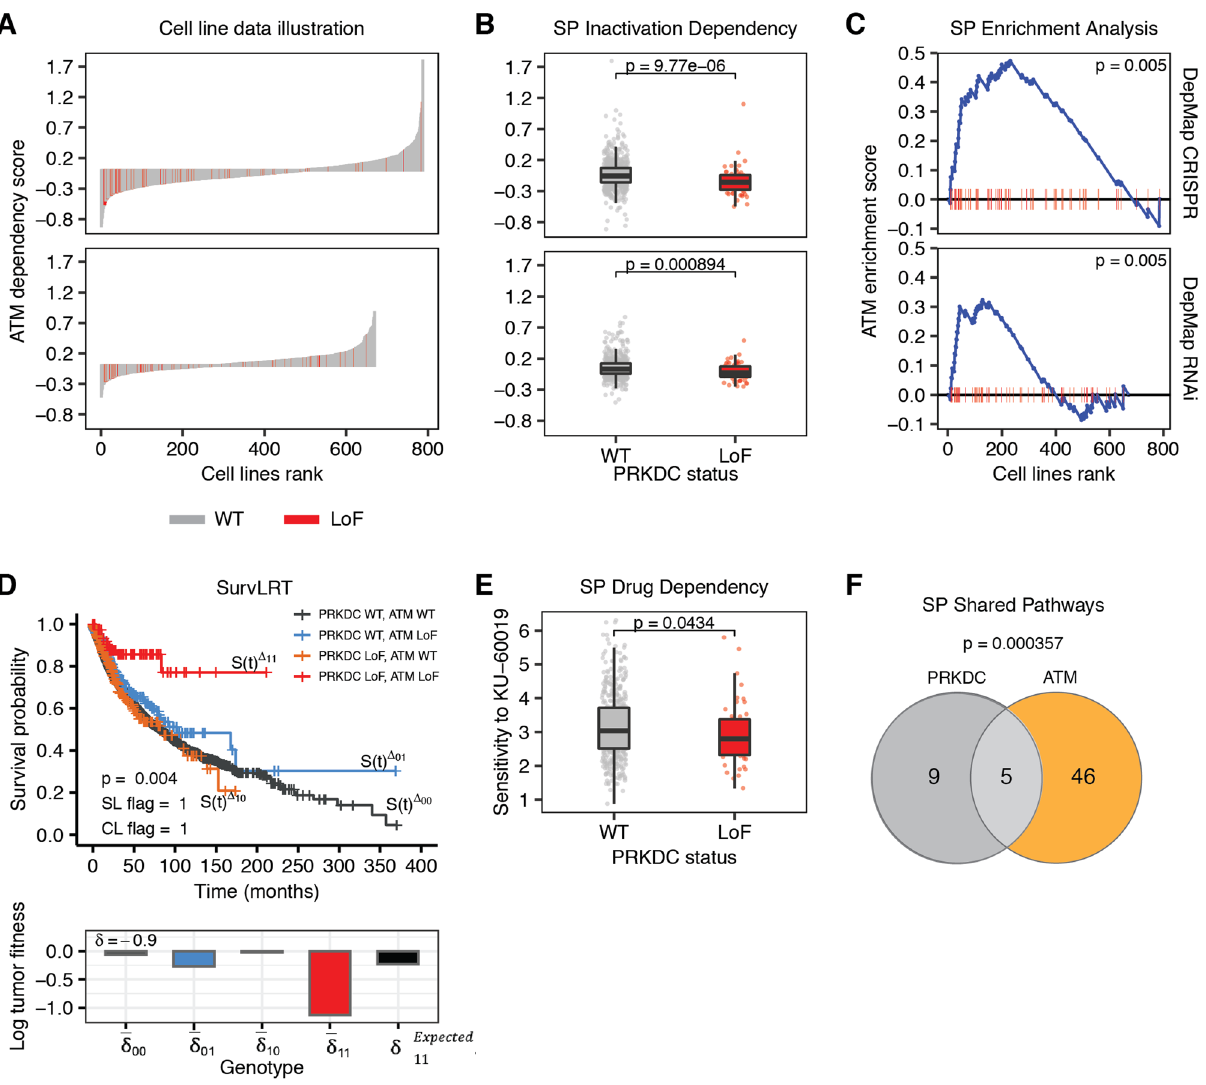
Figure 2. Evidence found in cell line, patient, drug and pathway data for the PRKDC and ATM SL interaction. Plots illustrating the results of tests that confirmed (significant p-value) the SL interaction between the pair. ( A ) Waterfall plots for Achilles (first row) and DEMETER2 (second row) datasets, illustrating the results of ATM knock-out experiments in cancer cell lines (sorted according to the effect size, cell lines having PRKDC LoF marked in red; x axis) with knock-out effect measured by dependency score (negative effect means that cells proliferate worse after the knock-out, positive - the cells proliferate better; y axis). ( B ) Boxplots illustrating SPID test results for Achilles (first row) and DEMETER2 (second row) datasets (y axis same as for panel A). ( C ) Plots illustrating SPEA test results for Achilles (first row) and DEMETER2 (second row) datasets; cell lines are sorted according to the dependency score (cell lines having PRKDC LoF marked in red; x axis); the blue line illustrates the calculations of ATM enrichment score (global maximum being the measured ES; y axis) that increases when encountering a cell line with PRKDC LoF, and decreases when encountering cell line with WT PRKDC . ( D ) The Kaplan-Meier survival plots illustrating SurvLRT test result with survival time in months (x axis) and calculated survival probability (y axis); the effect size for different PRKDC and ATM genotypes measured by log tumor Expected fitness are shown below, δ 11 value representing the effect size expected without SL interaction for double PRKDC and ATM LoF genotype. ( E ) Boxplots illustrating SPDD test result for GDSC dataset; the cells sensitivity to drug targeting PIK3CB is measured by natural logarithm of IC50 (ln(IC50)) (y axis). ( F ) Venn diagram illustrating SPSP test result with the number of common PRKDC and ATM pathways printed in the in cell line knock-out screens shows enrichment of negative dependency scores in cell lines with PRKDC LoF (red bars in Fig. 2A). For that pair, SPID test for the Achilles dataset identified that dependency of cell lines on ATM with PRKDC LoF alteration is significantly higher compared to cell lines without PRKDC LoF alteration (p-value 9.77 × 10 − 6 ; Fig. 2B first plot). SPEA confirmed that the cell lines with PRKDC LoF alteration are sig- nificantly enriched at the top of the list of cell lines as ordered by their sensitivity to CRISPR-mediated knock-out ATM knock-out (p-value 0.005; Fig. 2B first plot). Importantly, the same tests on the independent DEMETER2